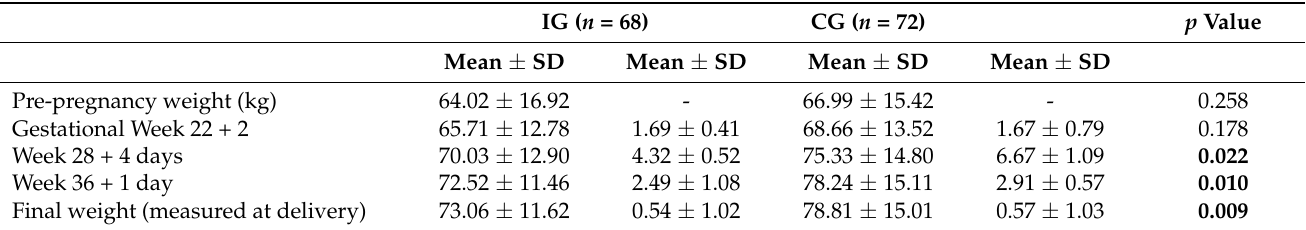
Table 4. Gestational mean weight (kg) and gestational weight gain (kg) in study groups for each measured time throughout pregnancy: IG—intervention group; CG—control